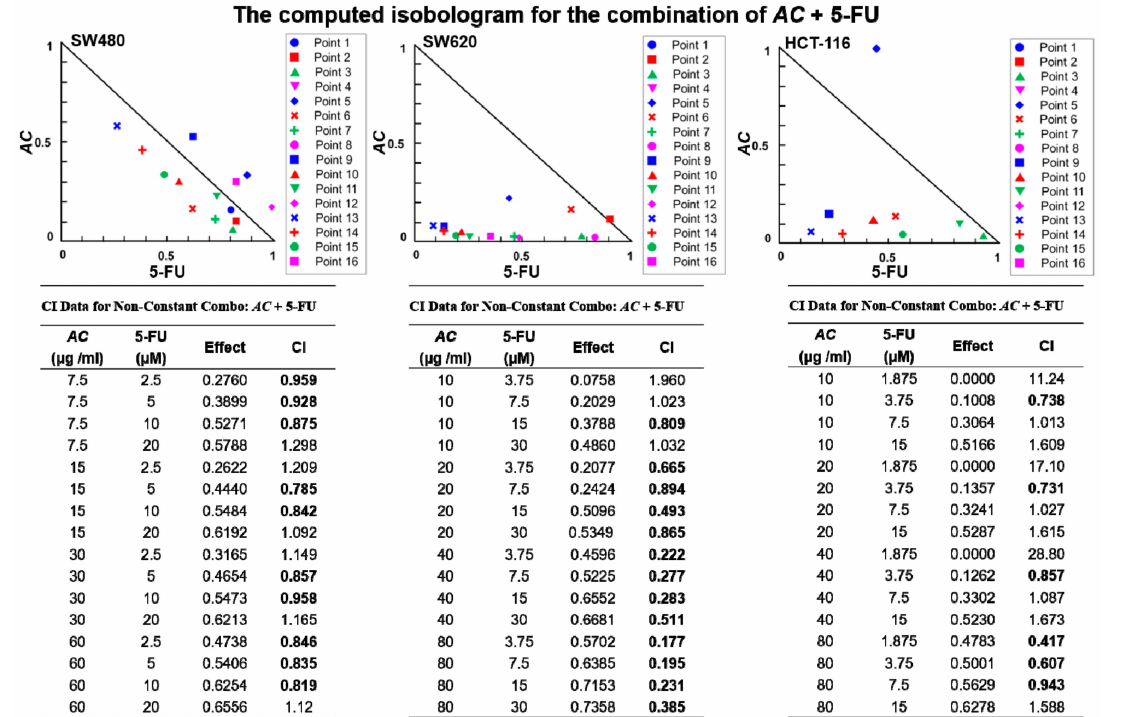
Figure 3. AC treatment increased 5-FU sensitivity in colon cancer cells. Drug combination assay, di ff erent concentrations of AC and 5-FU were used in combination for calculating the combination index (CI). Normalized isobolograms demonstrated a combination of AC and 5-FU synergistically suppressed the cell viability of colon cancer cells. CI values < 1 denotes